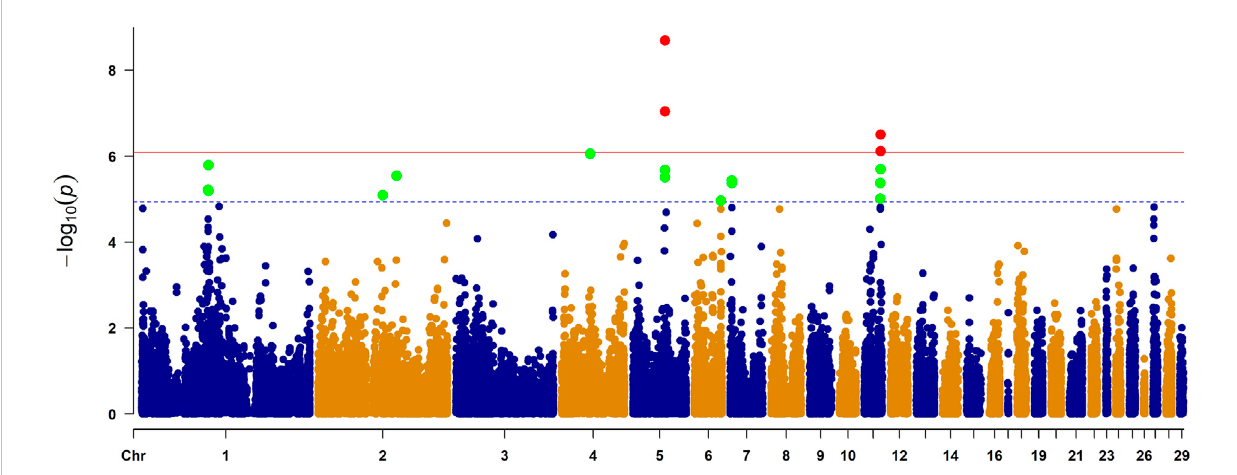
FIGURE 3 Manhattan plot of genome-wide study association study for the primary feather color trait in ducks. The X -axis represents the genomic position of corresponding SNP and the Y -axis represents − log 10 -tansformed p -value of the associations. Each dot represents each SNP. The red line represents p -value = 8.03 × 10 − 7 (0.05/62,266) for the Bonferroni adjusted genome-wide signi fi cance threshold, and blue line represents p -value = 1.61 × 10 − 5 (1/ 62,266) for the Bonferroni adjusted genome-wide suggestive signi fi cance threshold. Four genes reaching genome-wide signi fi cance were indicated in Manhattan plot, including STARD9 , ZNF106 , SLC7A5 , and BANP .